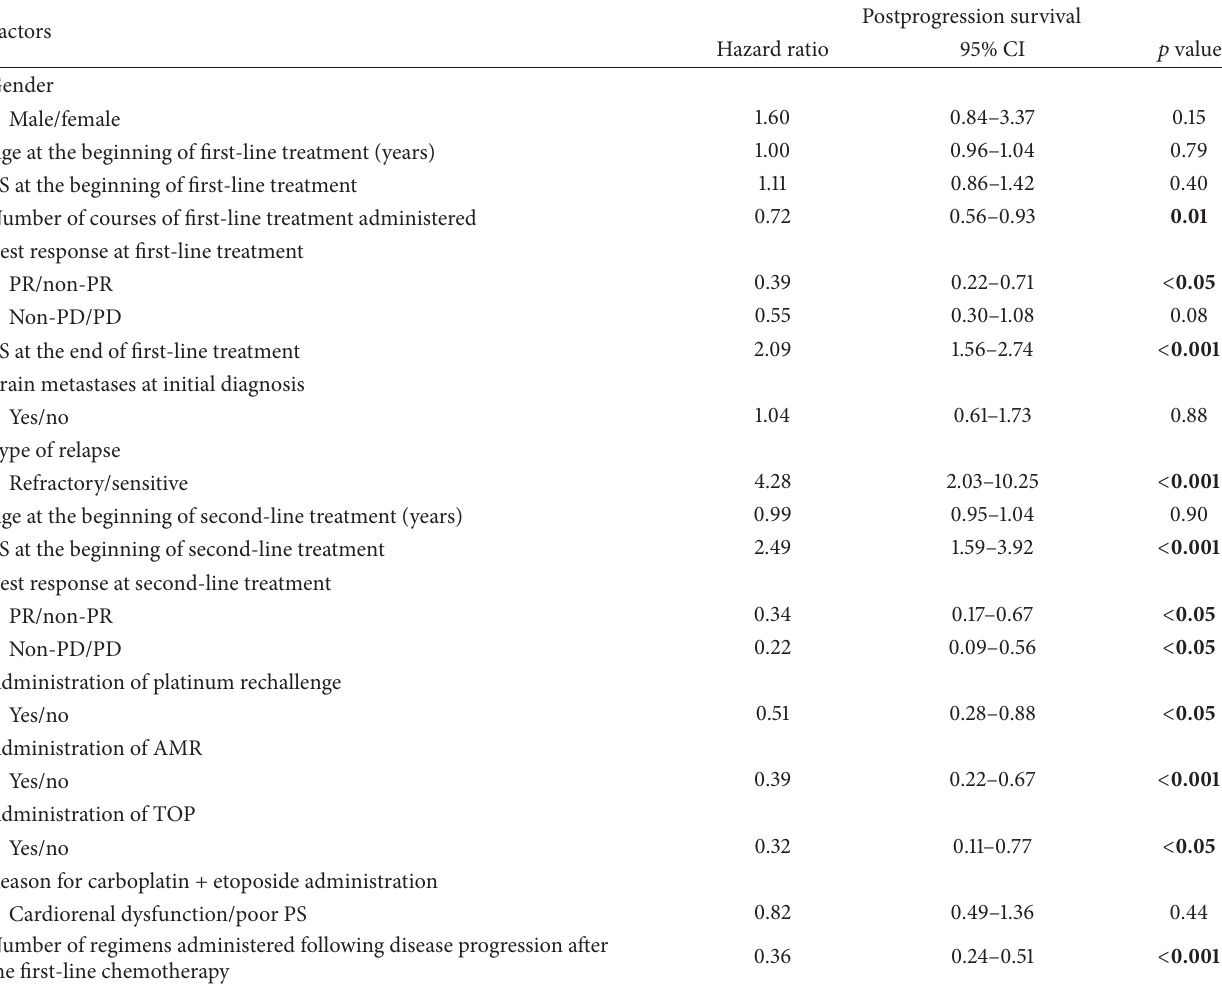
Table 3: Univariate Cox regression analysis of baseline patient characteristics for postprogression survival.